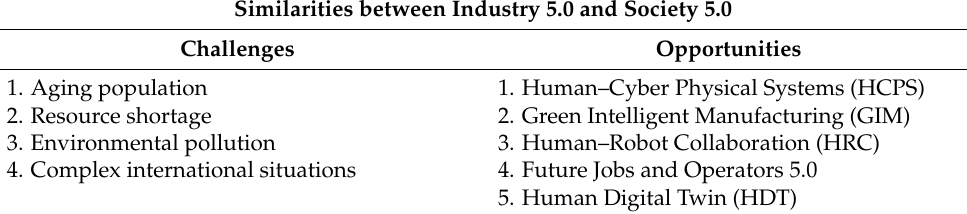
Table 7. Summary of challenges and